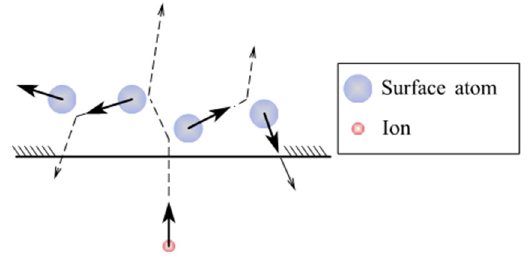
Figure 26. The series of collision processes [187].